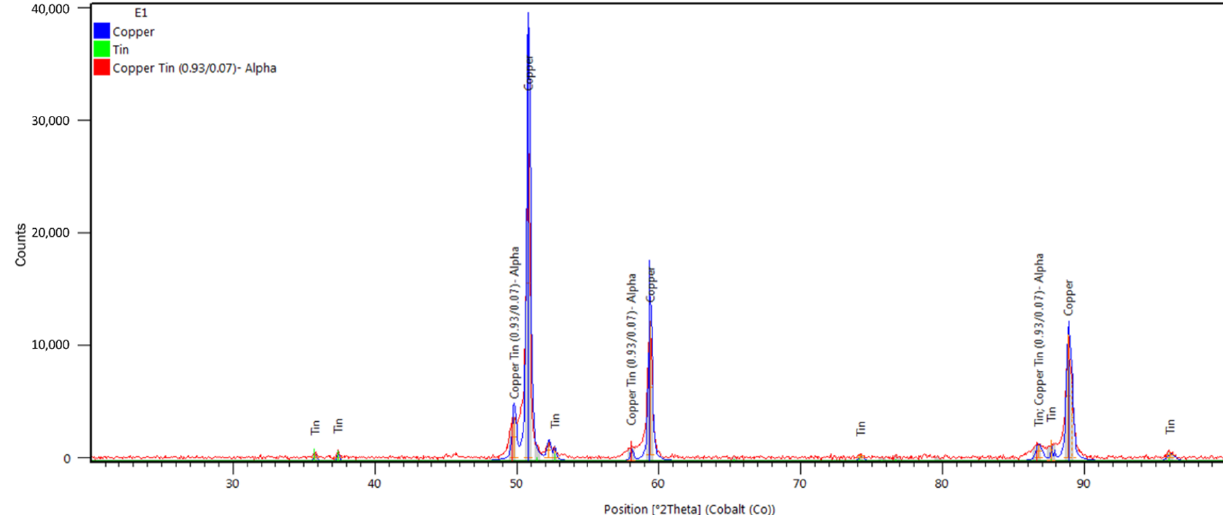
Figure 7. X-ray diffraction patterns of the concentrate.